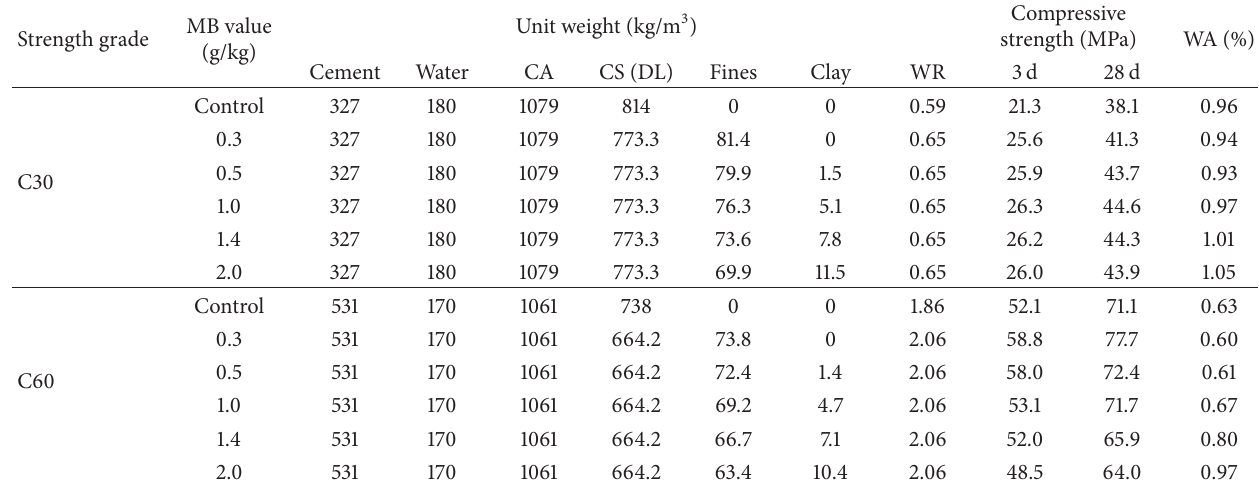
Table 4: Concrete mix proportions and strengths of resultant concrete.